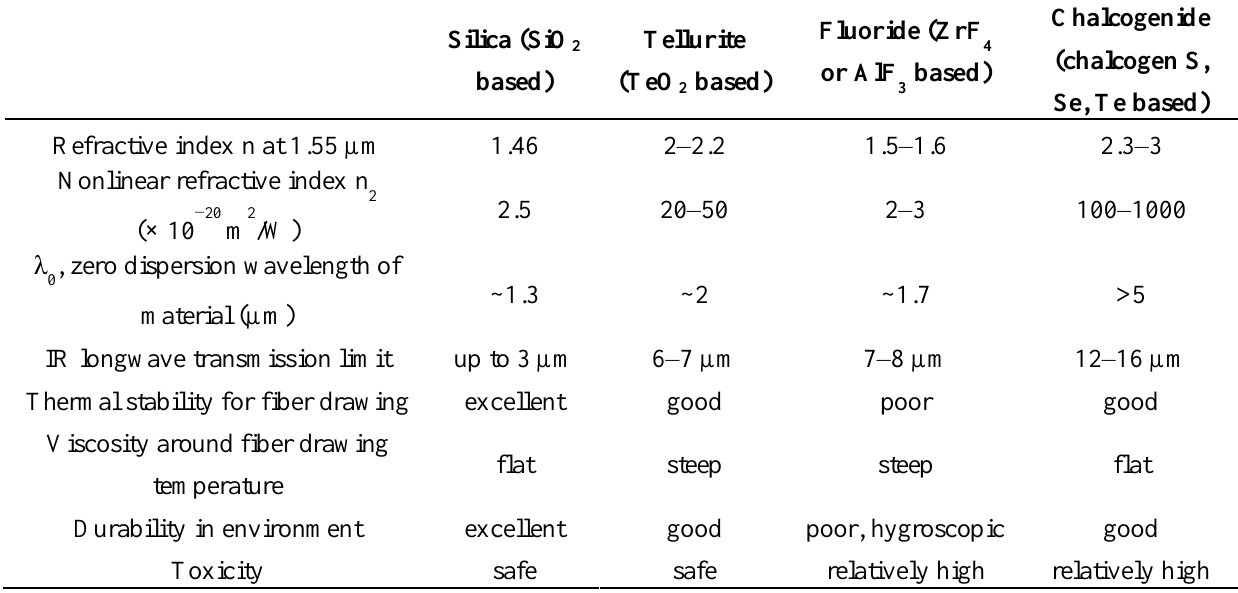
Table 1. Comparison of various optical glasses as host materials for mid-infrared nonlinear fibers